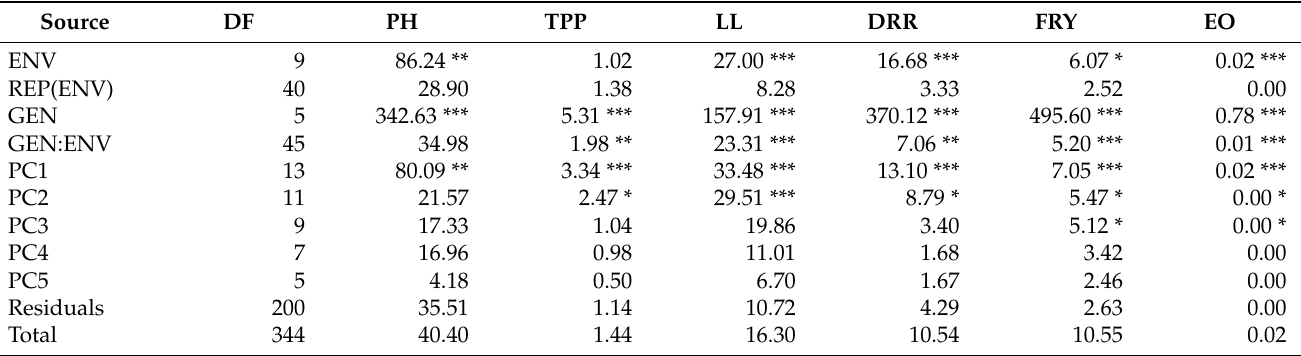
Table 4. AMMI analysis table for different agronomical traits of six high-yielding genotypes of C. caesia in the MLT.